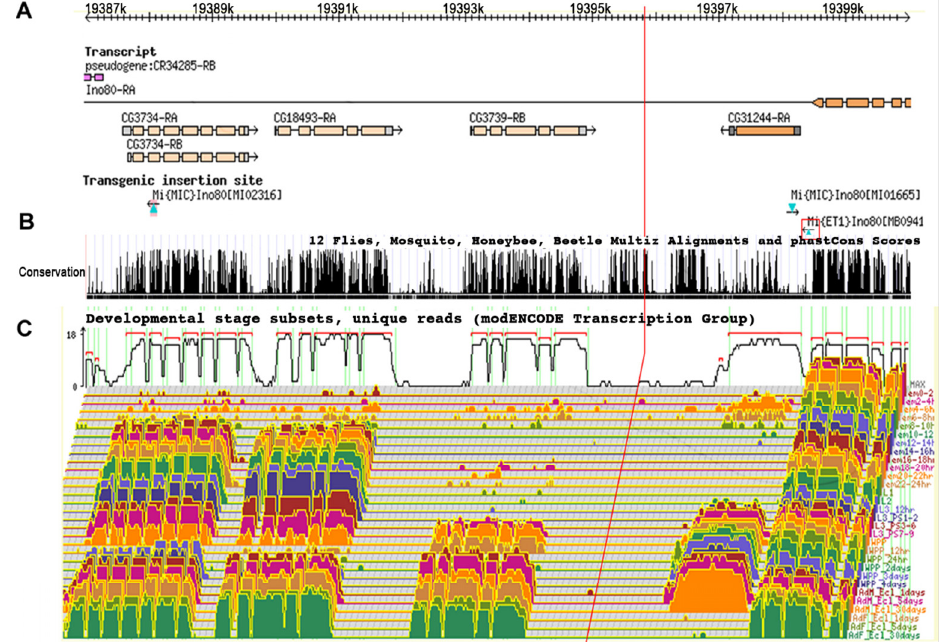
Figure 5. Genetic activity and conservation of the 15 kb Tel1 region. ( A ) The genes found in this region are aligned with molecular coordinates. Minos insertions used for mapping are shown in cyan triangles. Minos insertion M B09416 , which showed telomere elongation, is highlighted in the red square. ( B ) The University of California Santa Cruz genome browser map highlights sequence conservation in this region among different insect species. ( C ) A developmental transcriptome analysis for the same region as determined by the modENCODE project is also shown. The red vertical line spanning all three panels indicates the position of the TGT deletion.